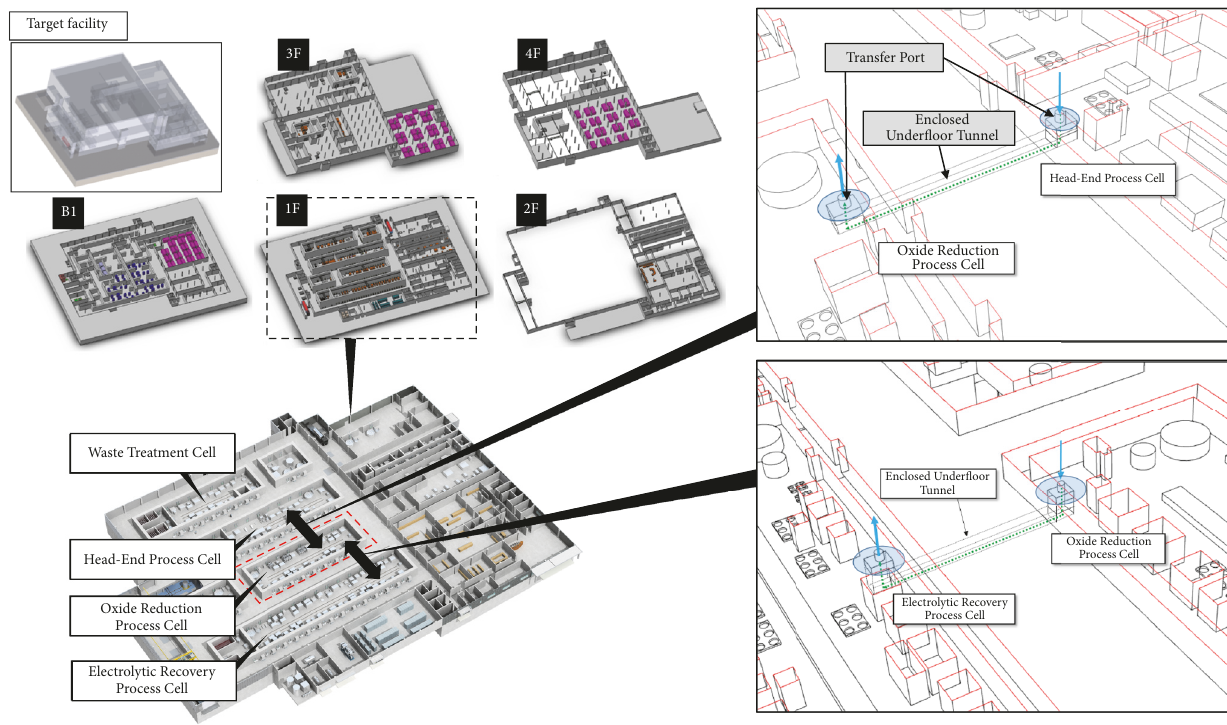
Figure 2: Floor plans and concept of the transportation tunnel between hot cells of the considered